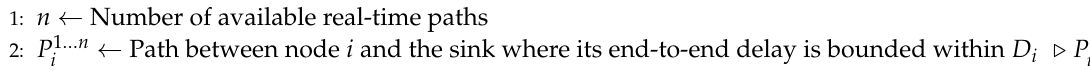
Algorithm 1 Adaptive QoS routing protocol for packet transmission from node i to the